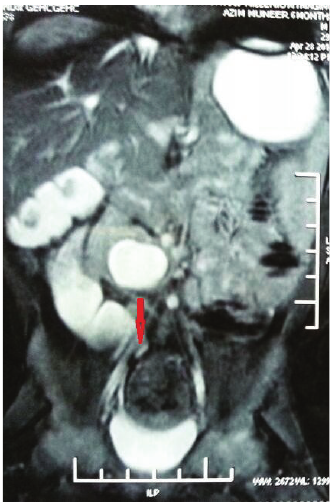
Figure 3: Red arrow shows a stricture site of left